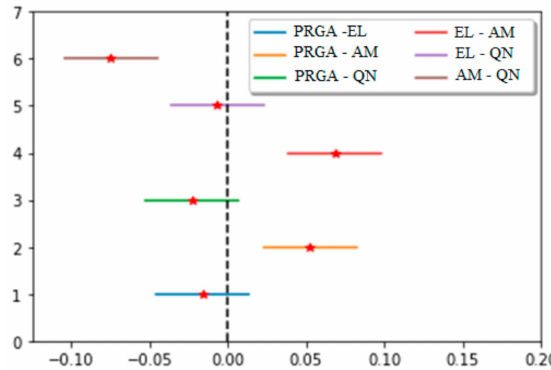
Figure 17. Tukey test: simulated cases.